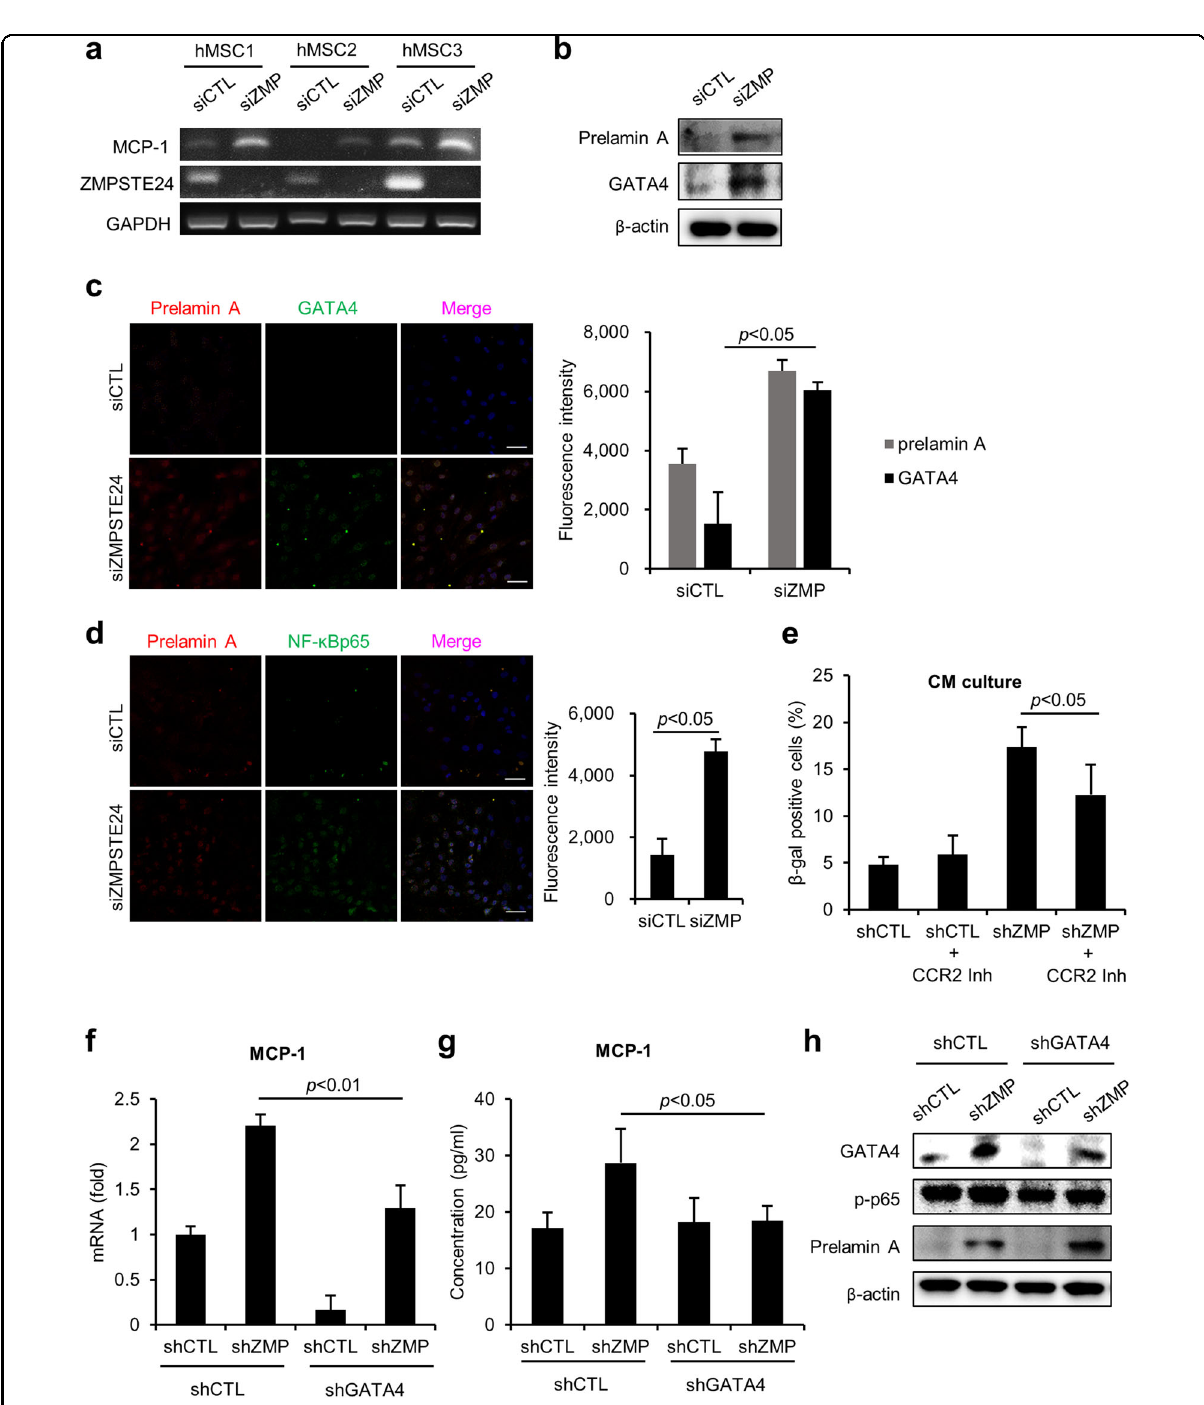
Fig. 5 GATA4 downregulation inhibits senescence in ZMPSTE24 depleted hMSCs. a After inhibition of ZMPSTE24 using siRNA, mRNA expression of MCP-1 and ZMPSTE24 was assessed by RT-PCR. b – d hMSCs were transfected with siControl and siZMPSTE24, and 2 days later, the indicated protein expression was determined. b Protein expression of prelamin A and GATA4 was analyzed by western blotting. c GATA4 and prelamin A expression in siCTL- and siZMPSTE24-transfected MSCs were determined by immunocytochemistry. Scale bar = 50 μ m. d The expression of NF- ĸ B was analyzed by immuno fl uorescence staining. Scale bar = 50 μ m. e hMSCs were infected with retrovirus expressing either shControl or shZMPSTE24. CM was collected from shCTL- and shZMPSTE24-infected hMSCs. hMSCs were grown in the CM in the presence of CCR2 inhibitor for 4 days. SA- β -gal staining was performed to determine senescent cells. f – h hMSCs were infected with retrovirus expressing a shRNA targeting ZMPSTE24 in combination with retrovirus encoding a shRNA targeting GATA4. After co-transduction of shGATA4 and shZMPSTE24, f mRNA expression levels and g secretion levels of MCP-1 from the indicated cells were measured. h The indicated proteins were analyzed by western blotting. Error bars represent means ± s.d. from three separate experiments. Student ’ s t -test was used for the statistical